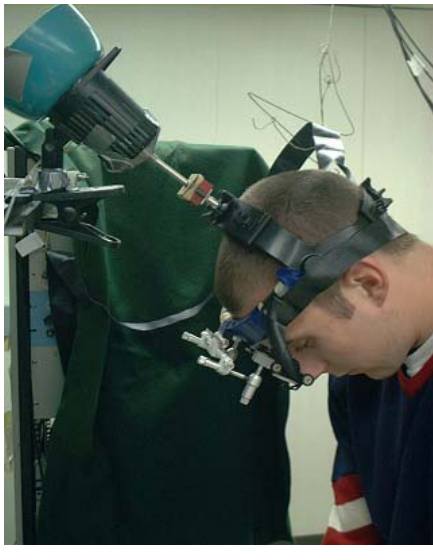
FIGURE 5 . The head movement sensor is assembled by attaching the female component in the head sensor swivel unit (see Fig. 4A) to the male component in the helmet (see Fig. 4B). The swivel unit is clamped onto a frame with three directions of freedom of movement. The swivel unit itself can be pivoted and rotated about its stem. This allows for different subject heights and head angles during the putting stroke. During the experimental setup, the shaft of the potentiometer that is attached to the swivel unit (see Fig. 4A) is aligned with the head in such a way that only rotation about an imaginary axis through the top of the head and its center-of-rotation will turn the potentiometer, which in turn provides the head rotation signal.